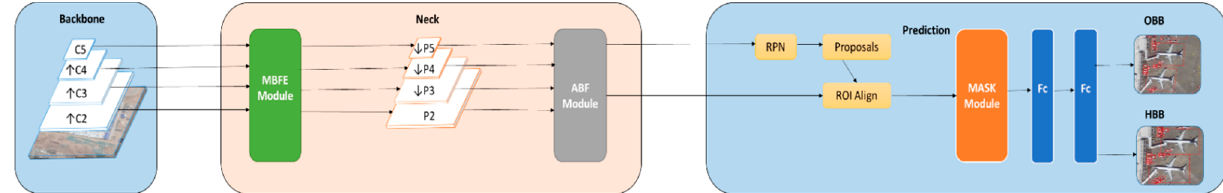
Figure 1. The framework of the proposed EFM-Net. EFM-Net consists of four main components: the backbone uses the ResNet and MBFE module to extract features, a background filtering module for background filtering, a mask improvement module for enhanced features, a detection module for object classification, and regression.